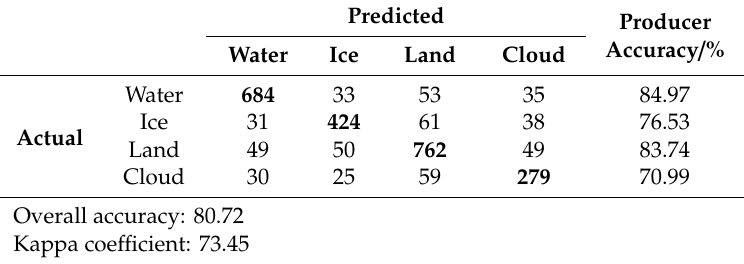
Table A2. Testing confusion matrix and accuracy of RF for four classes (The bold count stands for the predicted accurate class results; The accuracy of RF was expressed as the percentage).